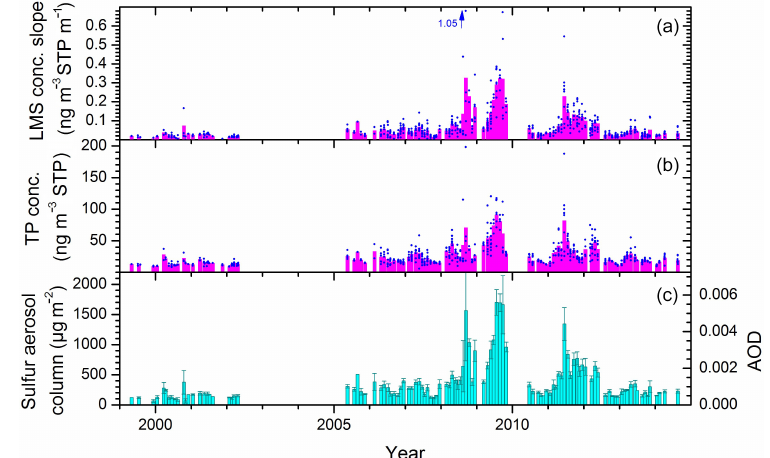
Figure 6. Estimated (a) slopes and (b) offsets based on individual measurements (dots) and monthly averages (magenta bars). (c) Sulfur aerosol column of the lowest 3000m of the LMS with standard errors, assuming particles of 75% sulfuric acid and 25% water, and AOD (right y axis) assuming stratospheric background aerosol particle size